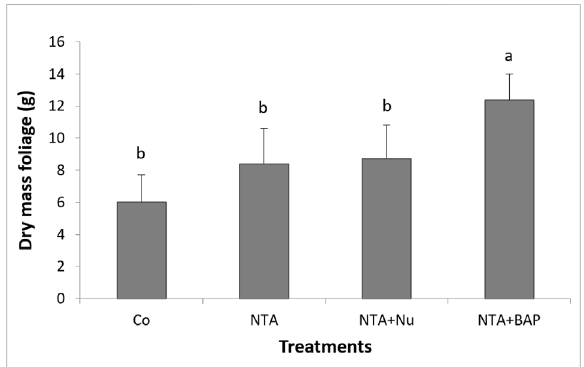
FIGURE 1 Average dry mass (g) (+SD) of Panicum virgatum per pot after fi nal harvest. Means for columns with same letters are not signi fi cantly different ( α = 0.05). (Treatments: NTA — 10mM NTA, Nu — foliarnutrientsapplicationofTriple-12 ® ,BAP-Promalin ® foliar application).